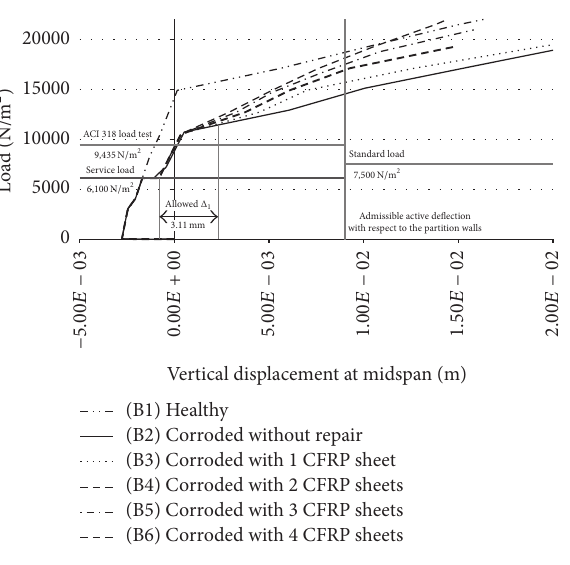
Figure 8: Load-vertical displacement at midspan curves for fixed- ended T-joist